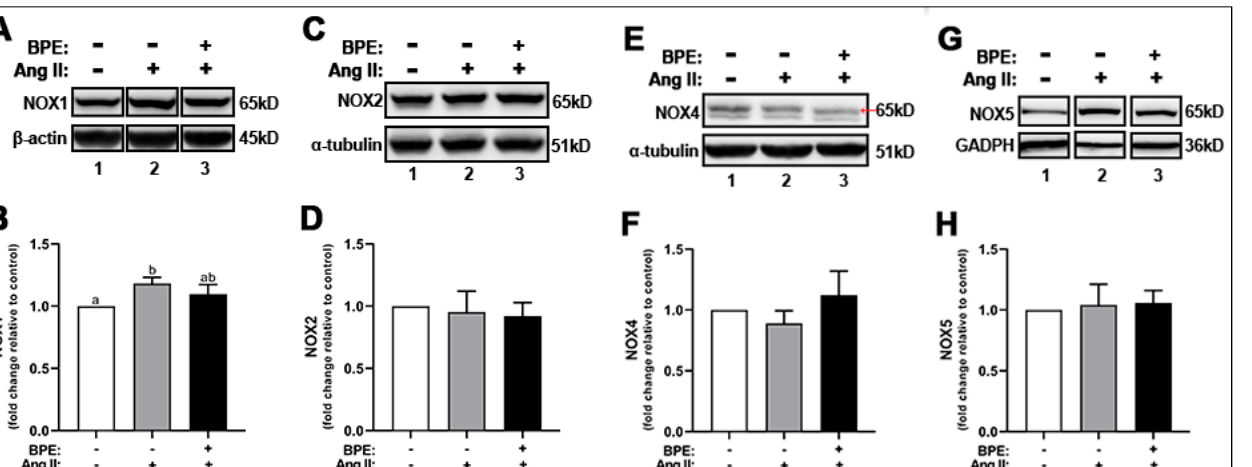
Figure 2. Blueberry polyphenol extract (BPE) attenuates SAPK/JNK and p38 phosphorylation in angiotensin (Ang) II-treated human aortic endothelial cells (HAECs). HAECs were treated with 200 µg/mL of BPE for 1 h then treated with 200 nM of Ang II for 12 h. Protein expression of phos- phorylated and total SAPK/JNK ( A , B ), ERK1/2 ( C , D ), p38 ( E , F ), and Akt ( G , H ) were determined by Western blot. Quantification was performed using Image Lab (Bio-Rad Laboratories, Inc., Hercules, CA, USA). Data are expressed as mean ± SD from three (SAPK/JNK), four (Akt) and five (ERK1/2 and p38) independent experiments. Values that do not share the same letter are significantly differ- ent from each other ( p ≤ 0.05).